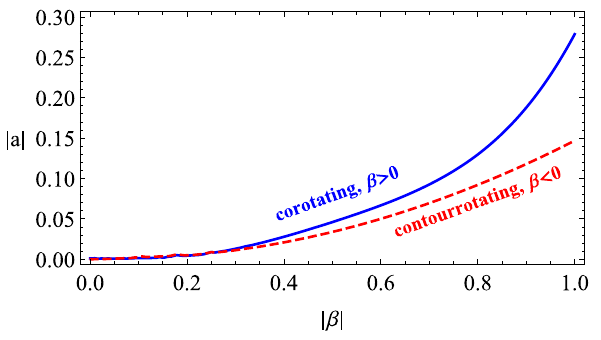
Fig. 13 The similar plot as Fig. 11, but for rotation and MOG param- eters